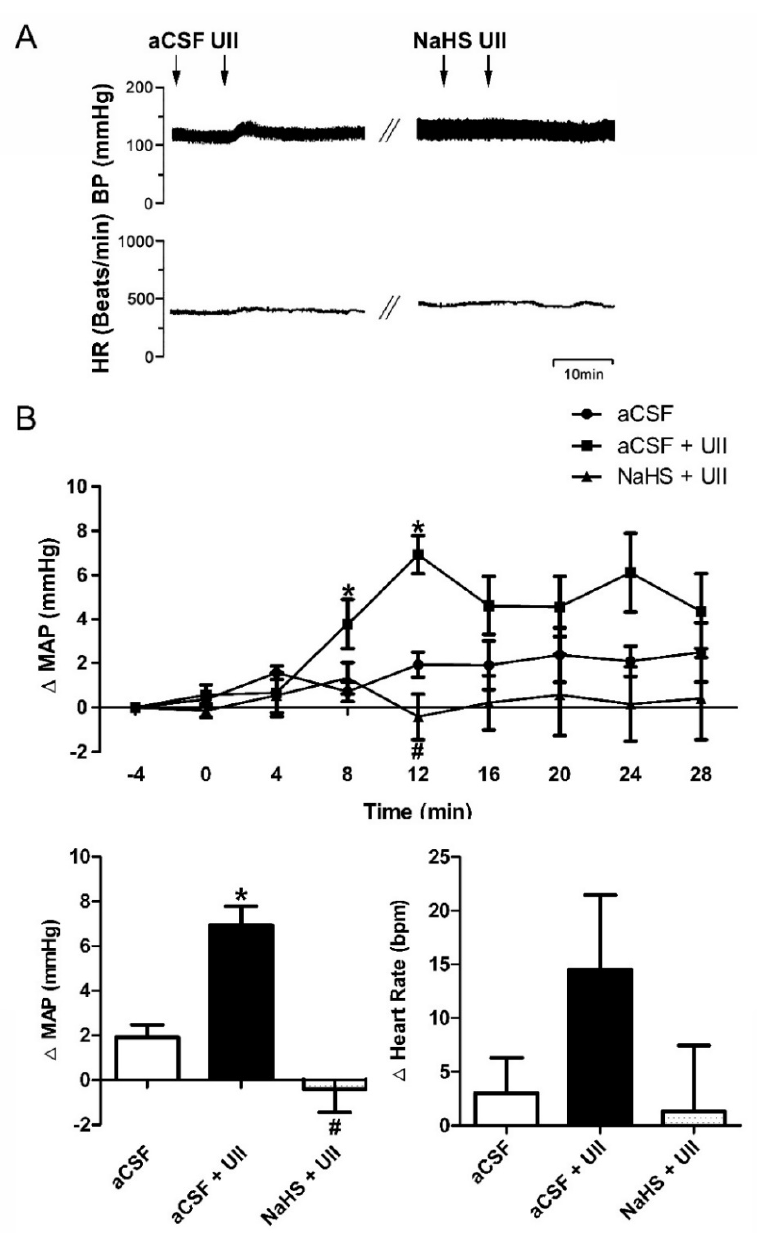
All nuclei are stained with DAPI ( C , G ). Figure ( D , H ) represent the overlay image. Western blots analysis showed UT and CBS expression ( I ). Confocal images showed a fluorescence micrograph of cells stained with anti-glutamate antibody (showed in green, ( J )). All nuclei are stained with DAPI ( K ). Figure ( L ) represent the overlay image. Bars = 50 µ m.